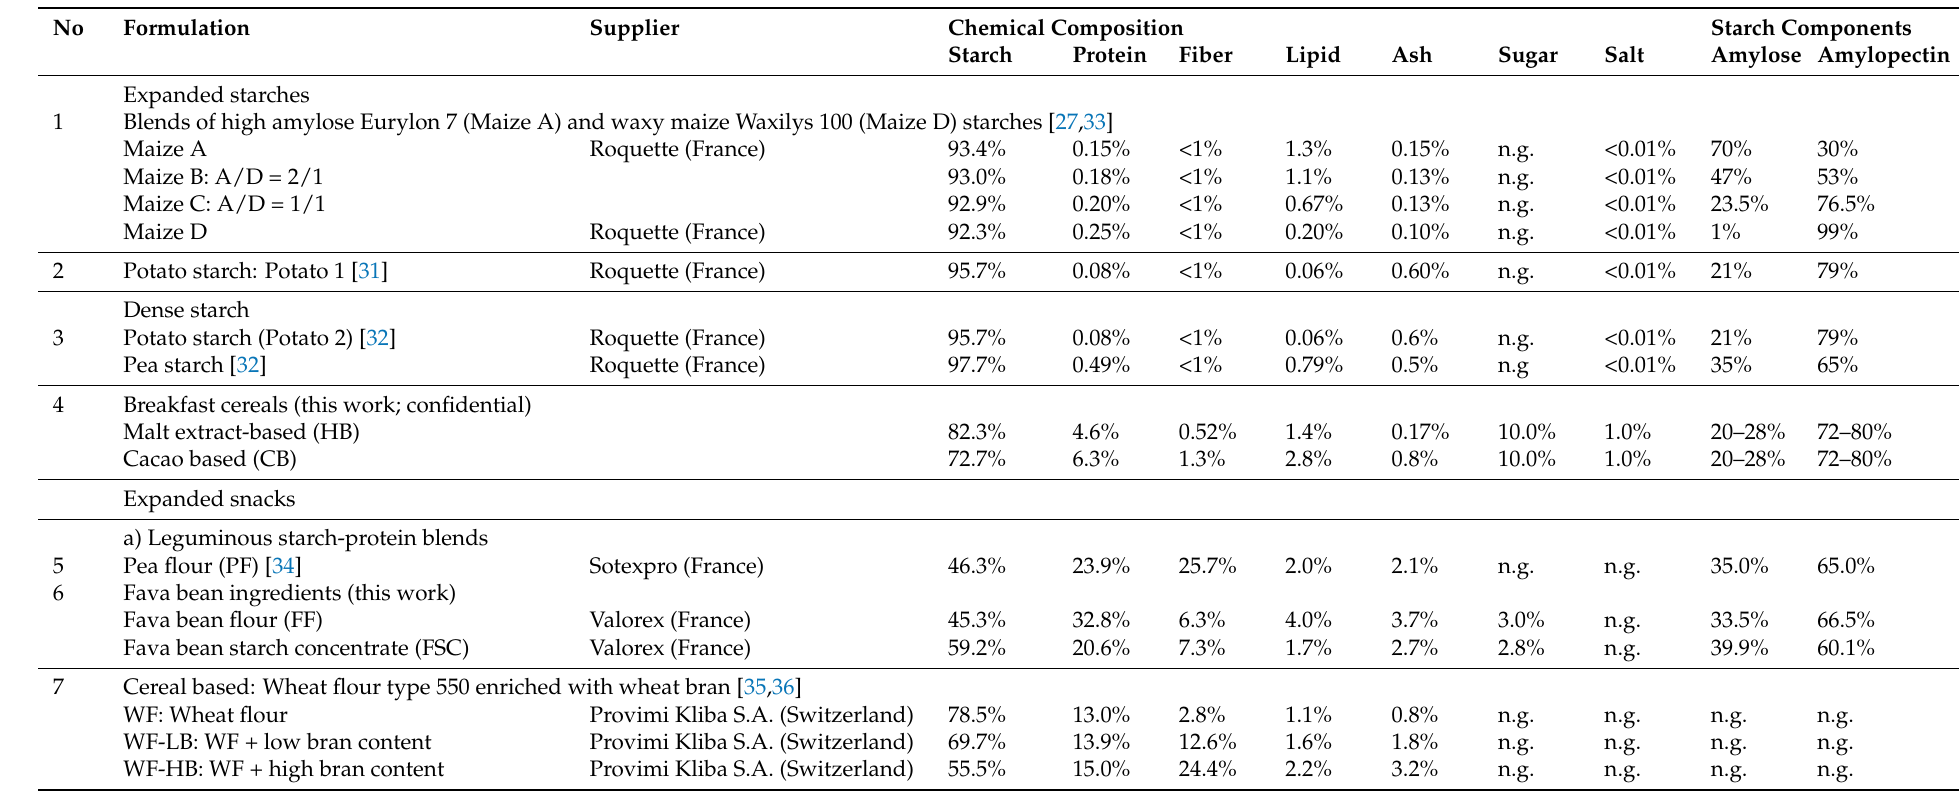
Table 1. Chemical composition of raw material, mostly provided by the